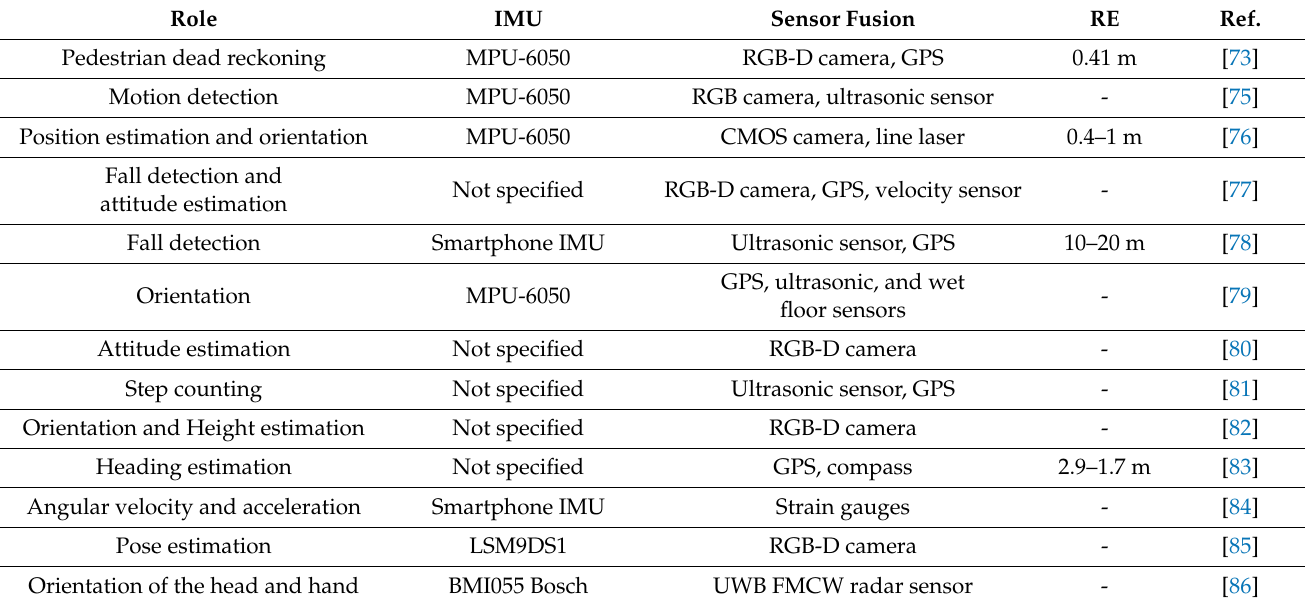
Table 3. Summary reviewed articles in the accelerometer and gyroscope fusion